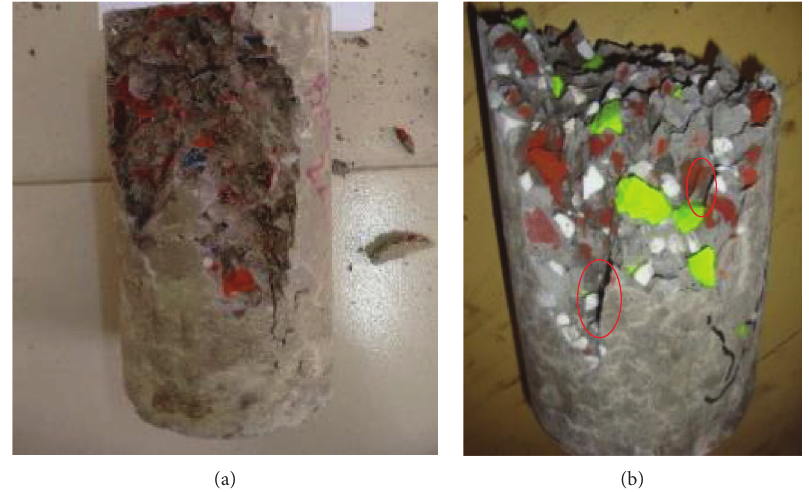
Figure 6: Failure of concrete cylinders with plastic aggregate subjected to compressive force. (a) PPC3-57. (b)